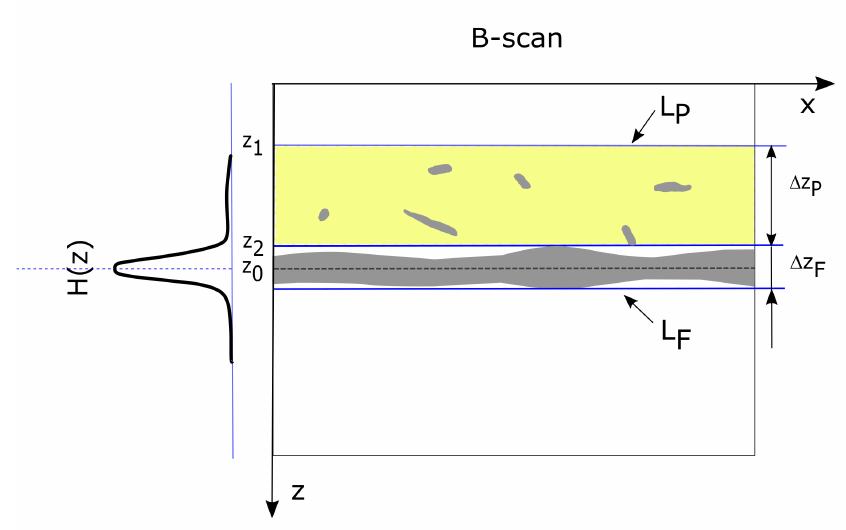
Figure 4. Layers inside the B-scan and their Hough transform in the horizontal direction x (at an angle of 90 ◦ ): L P —pilling layer; L F —fabric layer; ∆ z P —height of L F layer; ∆ z F -the height of L F